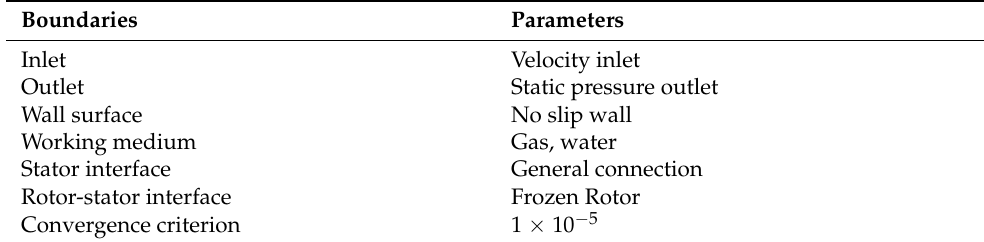
Table 1. Settings of the boundaries and